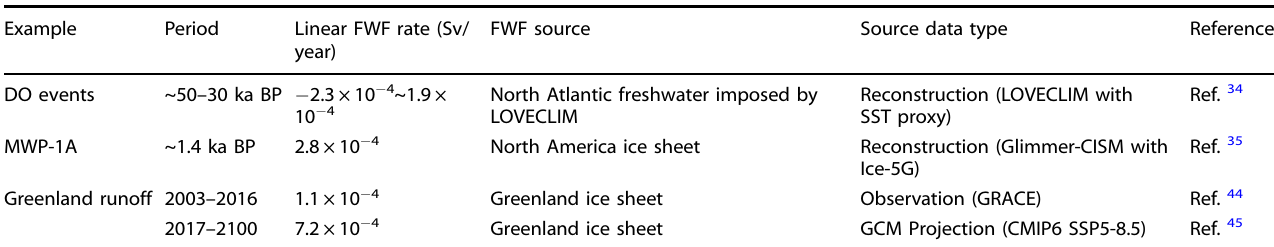
Table 1. The estimated rates of